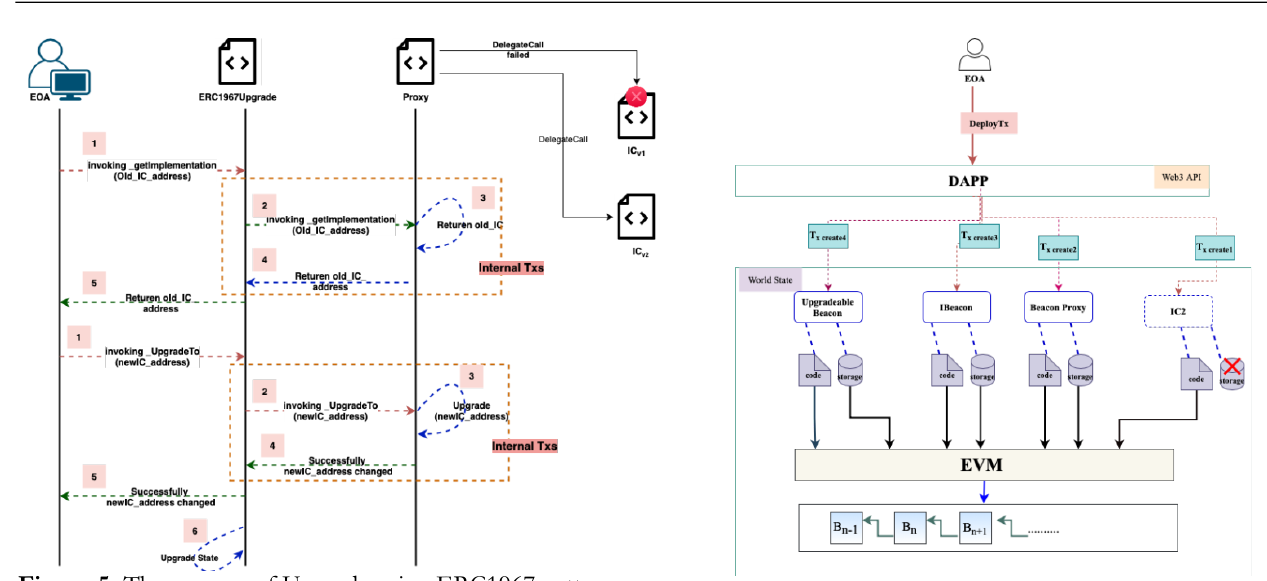
Figure 5. The process of Upgrade using ERC1967 pattern